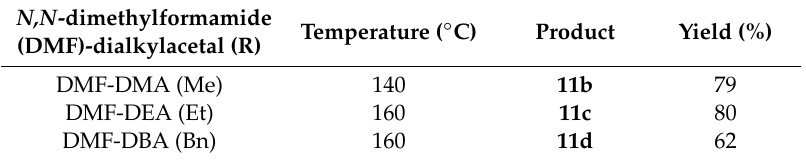
Table 3. Kinase inhibitory potencies (IC 50 in μ M) 1 for compounds of the series 1, 2, 3, and 4.